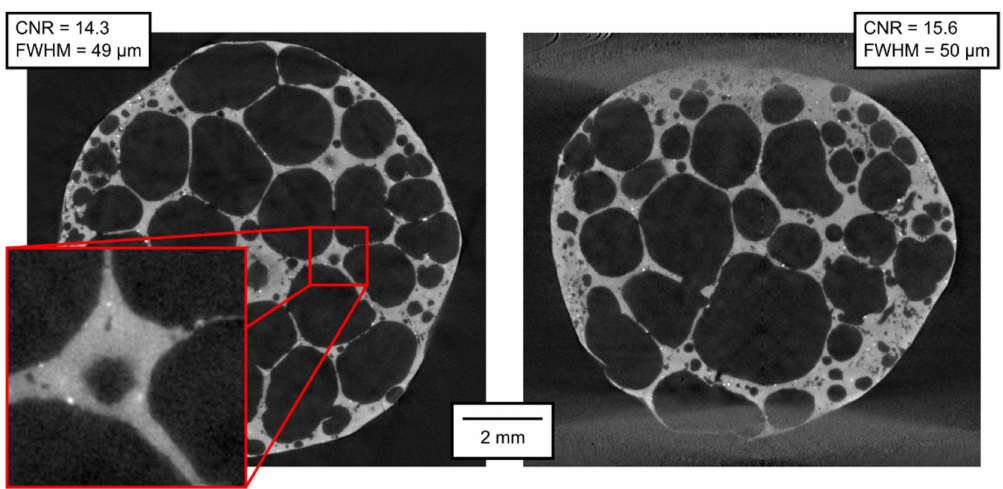
Figure 8. Transversal and lateral central section of the 3D reconstructed volume, Mode